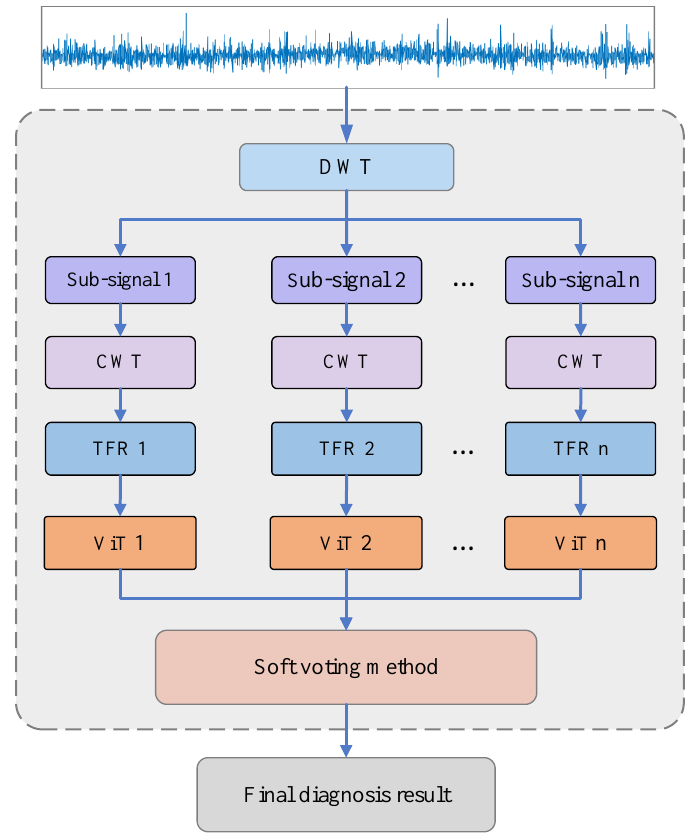
Figure 1. The diagnosis scheme diagram of the proposed integrated